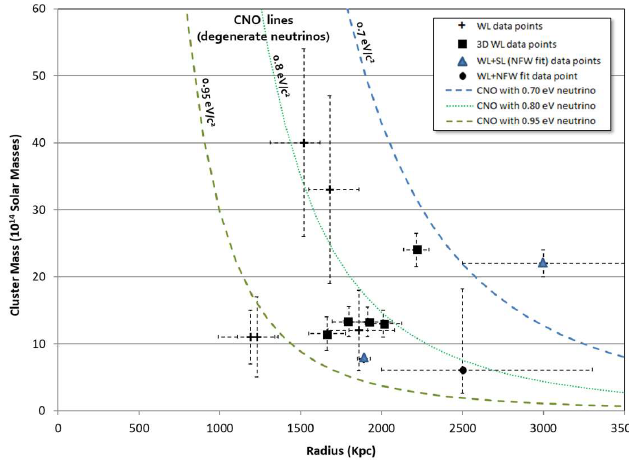
Figure 4. The plotted virial mass and radii from identified weak lensing data.